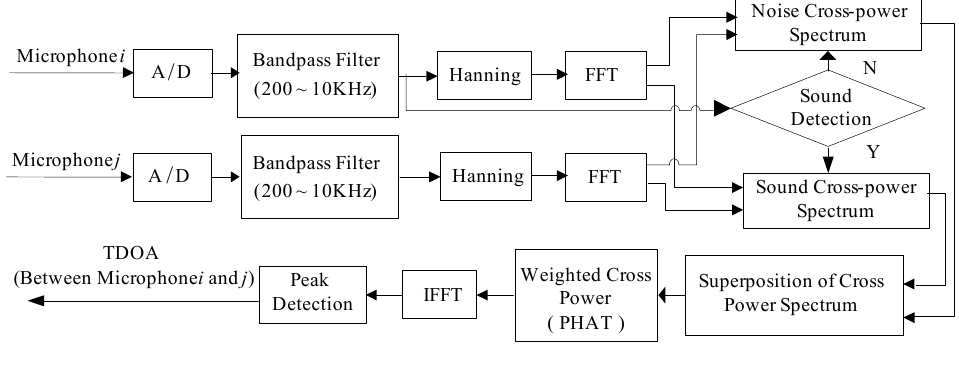
Figure 7. Architecture of TDOA by IGCC.